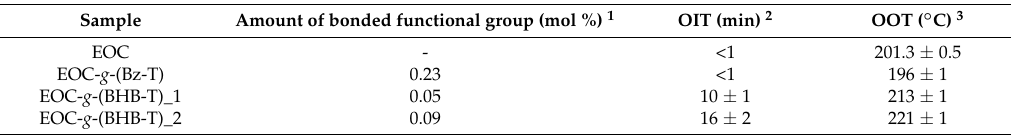
Table 3. Oxidation Induction Time (OIT) and Oxidation Onset Temperature (OOT) values for EOC functionalized with Bz-T and BHB-T.